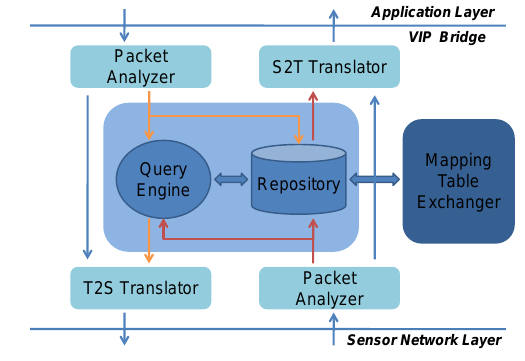
Figure 5. Components of VIP